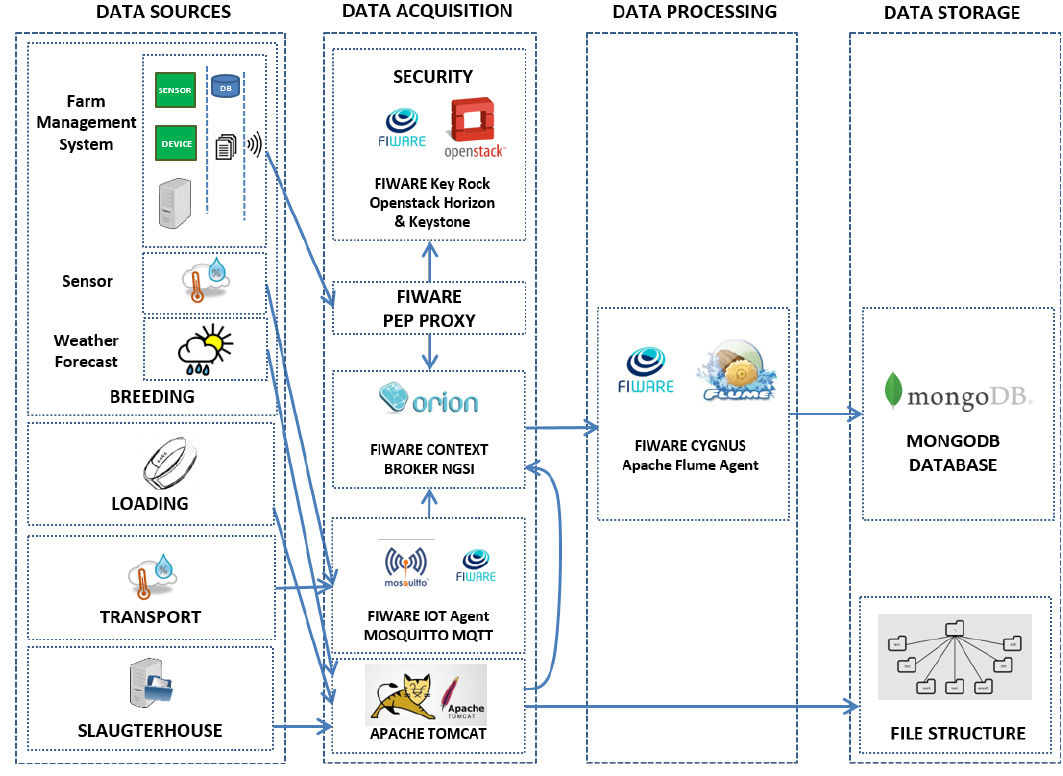
Figure 3. The PCM platform data